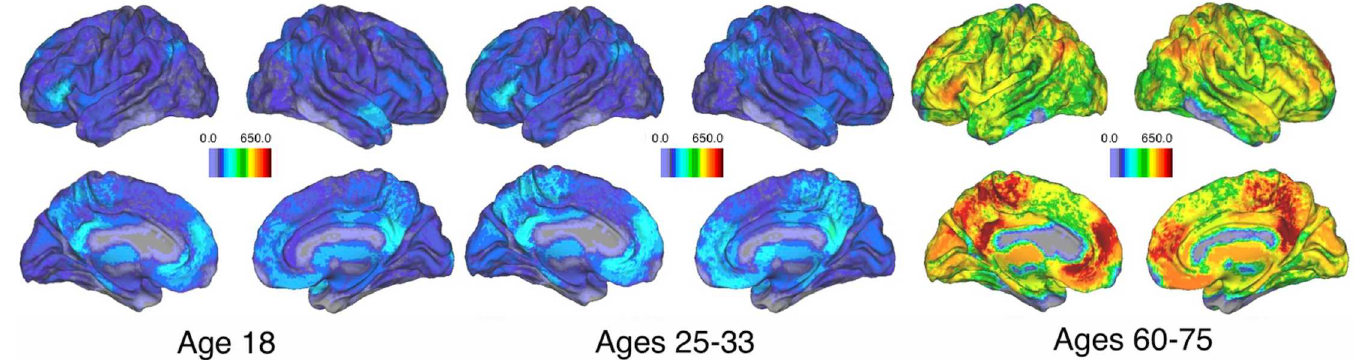
Fig 11. Spatial distribution of hyperedges for three age groups. Average hyperedge node degree for three discrete age groups in the age-memory study. Regionsof relative high node degree are consistent across the three groups, but the overallnode degree is about five times larger in the group with ages from 60–75. This correspondsto previous observations of increasingcardinality with age and illustrates how the increase in cardinality is spread across the